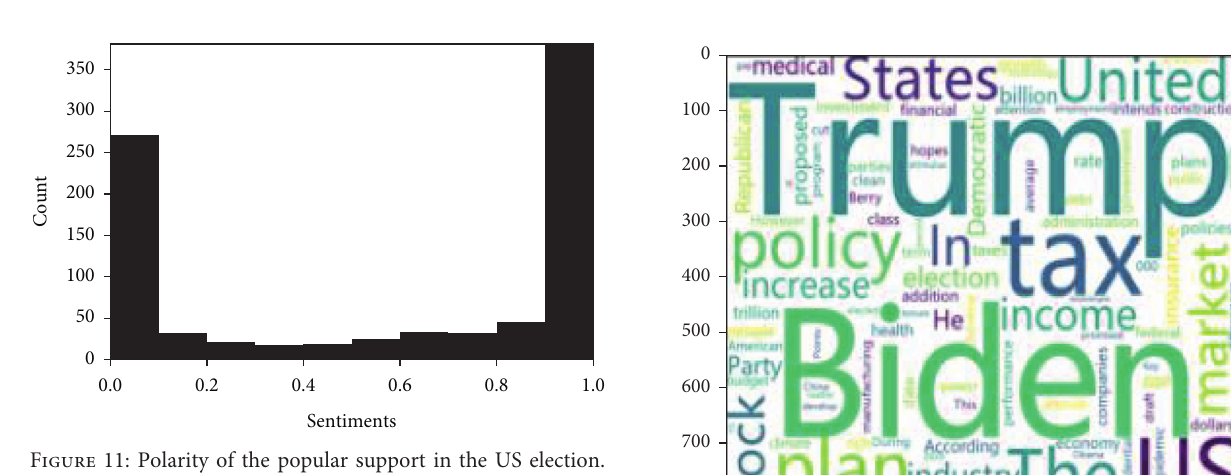
Figure 10: Total value of the time series forecast trend in China.